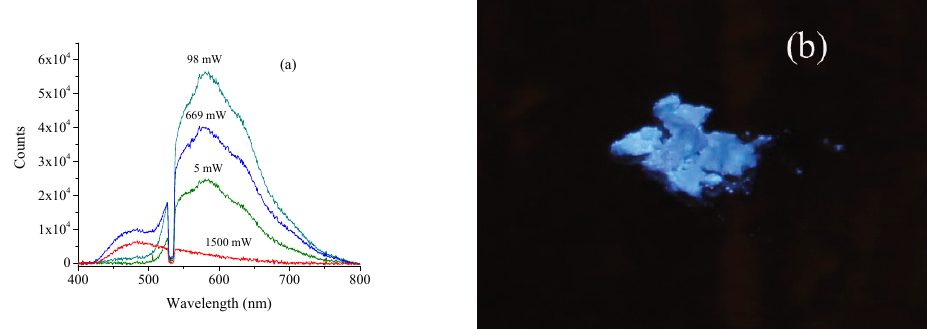
Figure 1. ( a ) Power dependence of the visible fluorescence signal of s -C 3 N 4 . Measured powers in mW are displayed in the table. ( b ) Photos of the s -C 3 N 4 powder illuminated by a green laser 1500 mW. s -C 3 N 4 and g -C 3 N 4 forms of carbon nitride [8], we compared the fluorescence of these forms under pulsed laser illumination. The results of the measurements of the g -C 3 N 4 are shown in Figure